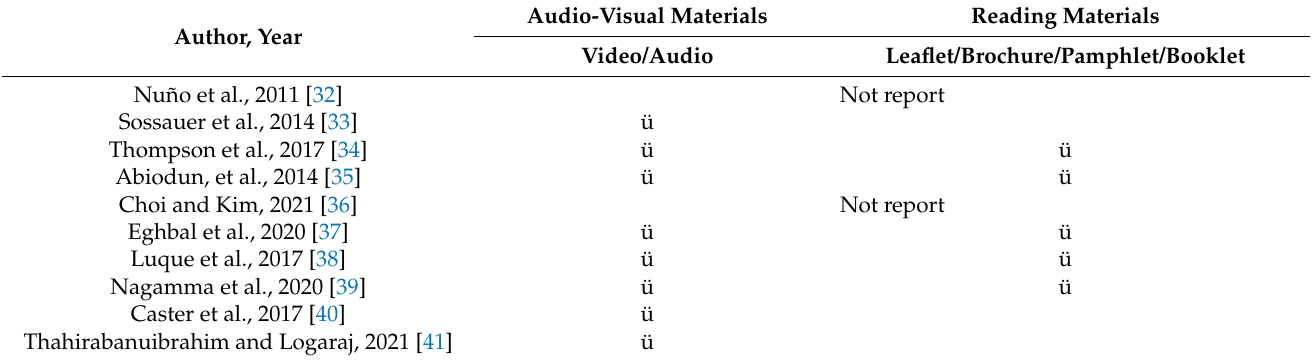
Table 6. Educational materials.